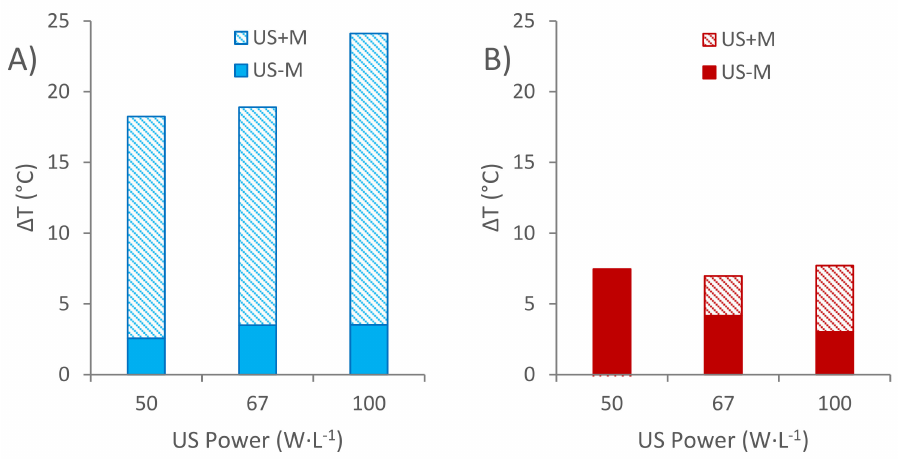
Figure 7. Theoretical temperature increment comparison related to Peleg’s ( A ) K 1 and ( B ) K 2 constants between non-pumped sonicated extractions (US-M) and pumped sonicated extractions (US +